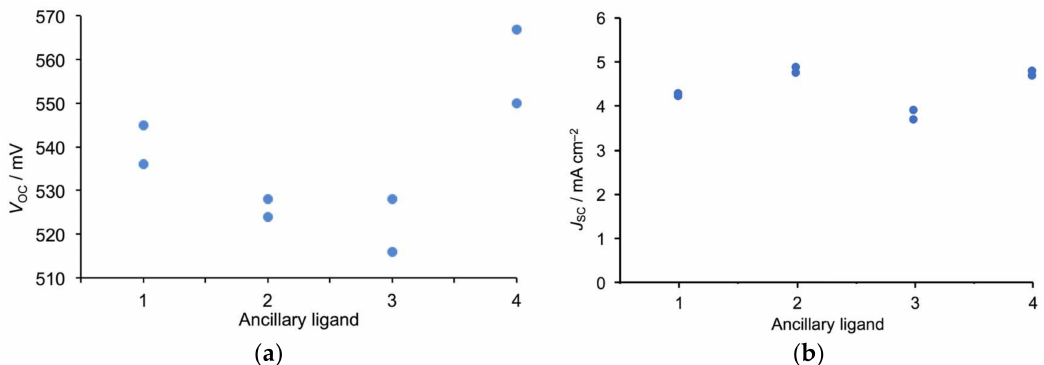
Figure 8. Trends in values of ( a ) V OC and ( b ) J SC for duplicate DSSCs containing the dyes [Cu( 5 )( 1 )] + (Ph groups), [Cu( 5 )( 2 )] + (4-MeOC 6 H 4 groups), [Cu( 5 )( 3 )] + (3,5-(MeO) 2 C 6 H 3 groups), or [Cu( 5 )( 4 )] + (3,4,5-(MeO) 3 C 6 H 2 groups).